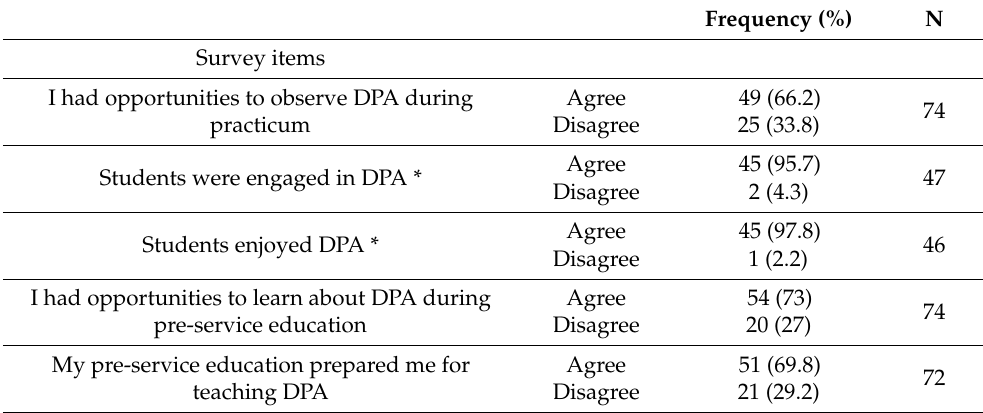
Table 3. Pre-service teachers’ experience with DPA implementation during their educational